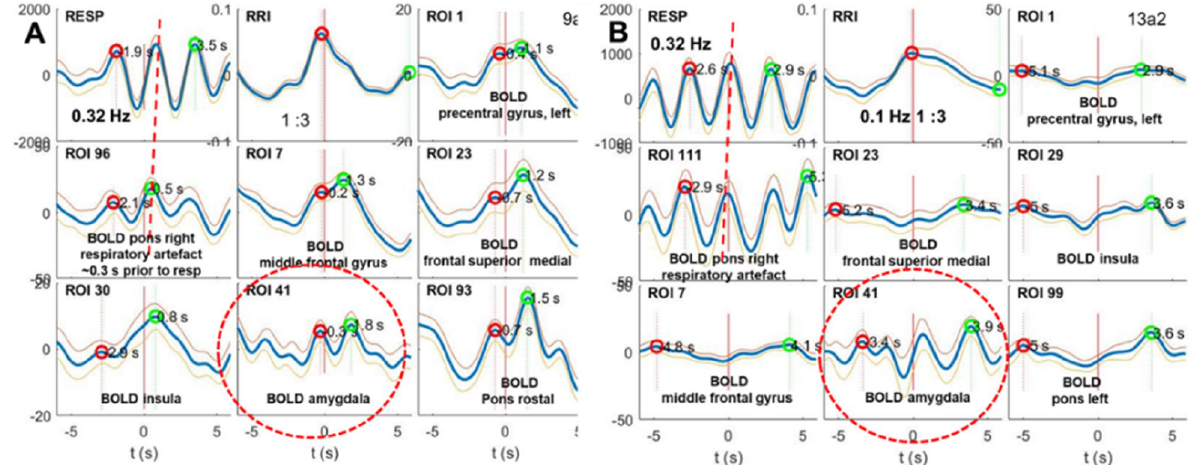
Figure 2. Examples of RRI peak (longest RR interval)-triggered breathing, RRI and BOLD waves (mean + − SE) from two subjects (panel A and B ) with prominent respiration at ~ 0.32 Hz. The locations of ROIs used for BOLD recordings are indicated. Note the BOLD artefact induced by vessel motion of the basilar artery in right pons/brainstem preceding respiration, measured from a chest belt (stippled vertical line). BOLD oscillations from amygdala are marked by stippled circles.